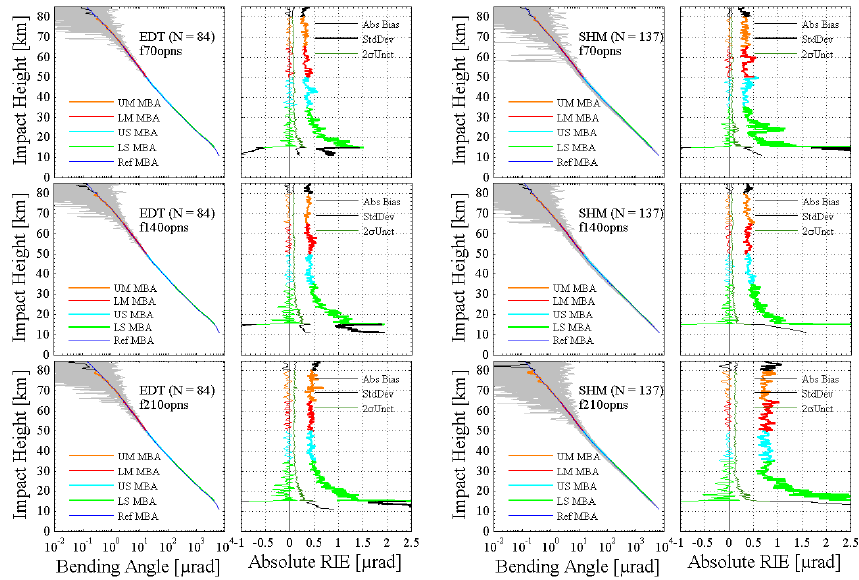
Figure 7. Ionosphere-corrected bending angle profiles and their statistical results for the EDT (left) and SHM (right) “opns” data sets. The figure layout and legends are the same as in Fig.